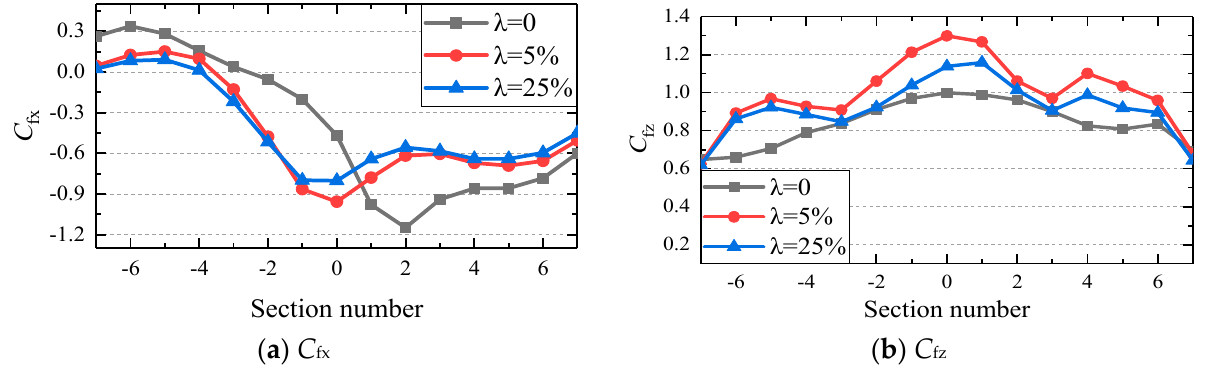
Figure 17. Variations in mean sectional aerodynamic load coefficients across car with ground roughness ( S = 0.35). ( a ) C fx ; ( b ) C fz .